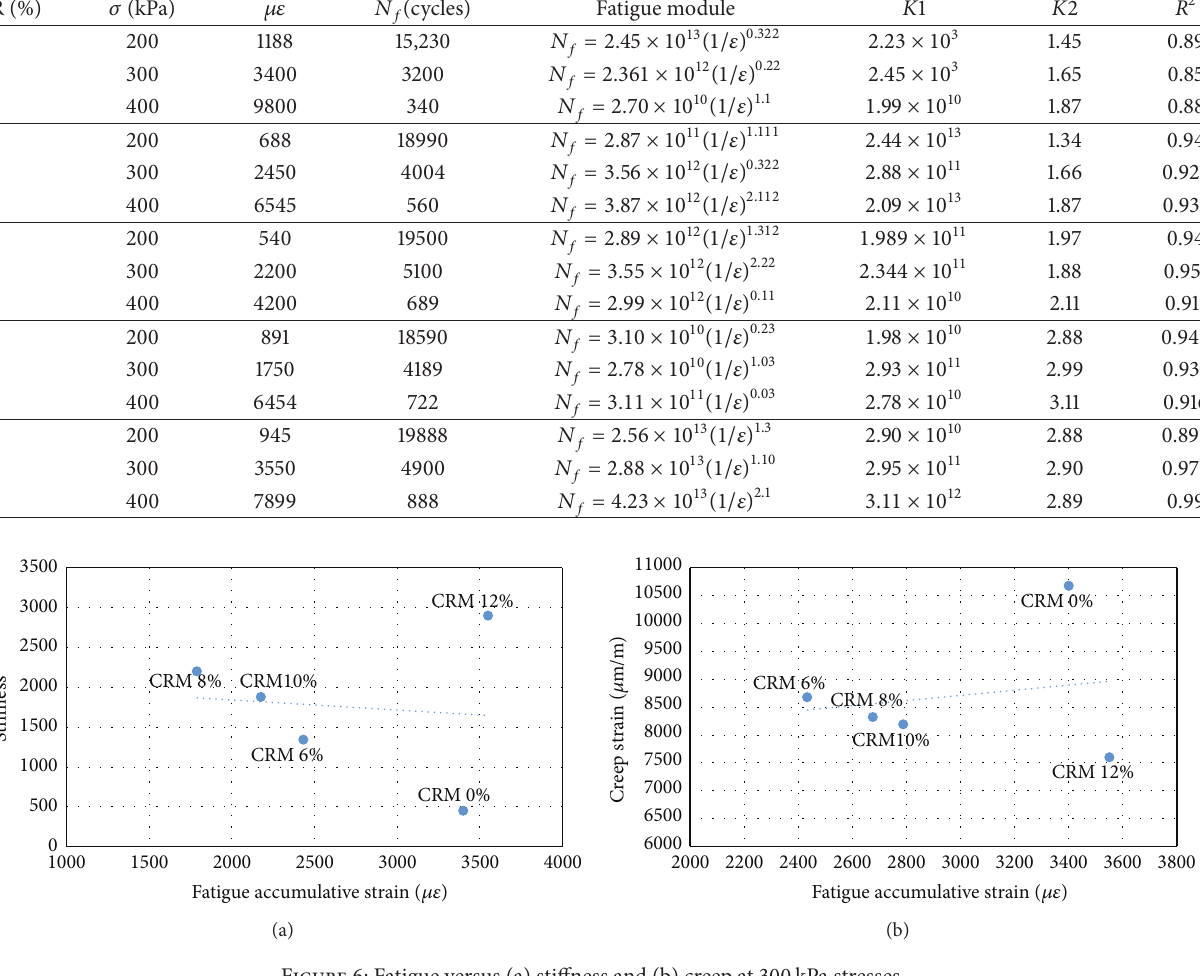
Figure 6: Fatigue versus (a) stiffness and (b) creep at 300 kPa stresses.